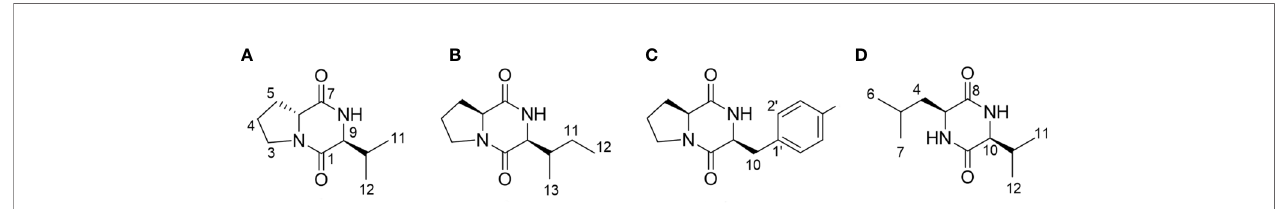
FIGURE 3 | Structural analyses of the isolated diketopiperazines from Bacillus thuringiensis JCK-1233. (A) cyclo -(D-Pro-L-Val), (B) cyclo -(L-Pro-L-Ile), (C) cyclo -(L- Pro-L-Phe), and (D)